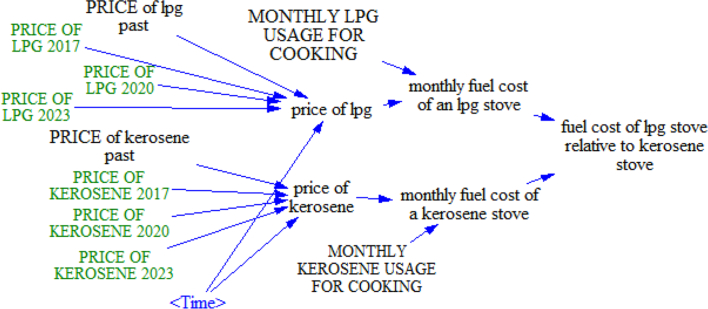
Formulation of fuel cost of LPG stove relative to kerosene stove.